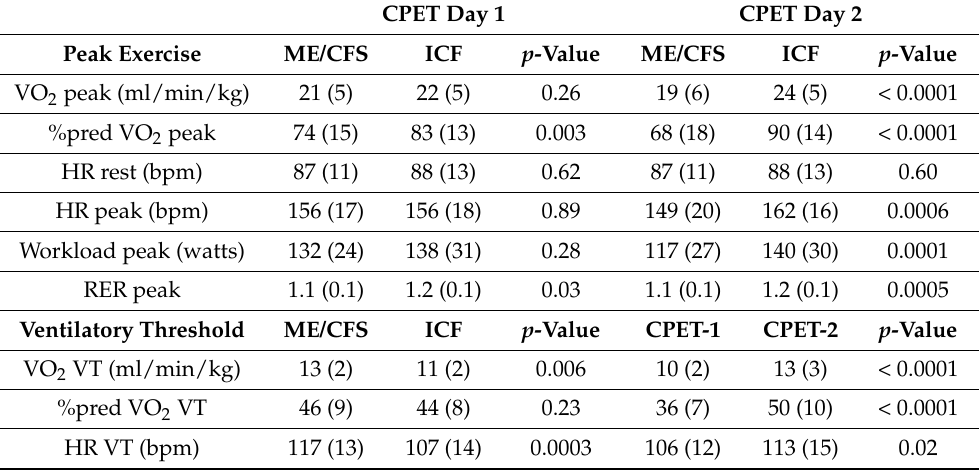
Table 3. CPET-1 variables in ME/CFS compared to ICF females (left side) and CPET-2 variables in ME/CFS compared to ICF females (right side).